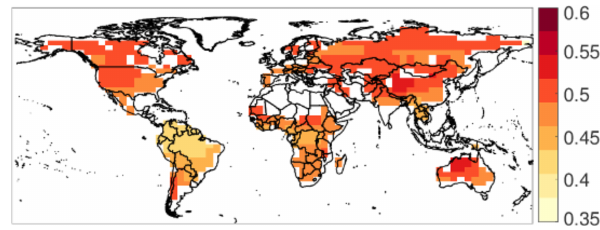
Figure 2. Global variations in mean carbon use efficiency from